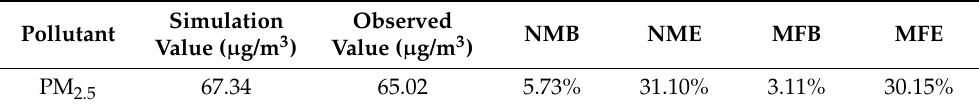
Table 4. Evaluation results of simulated effects.